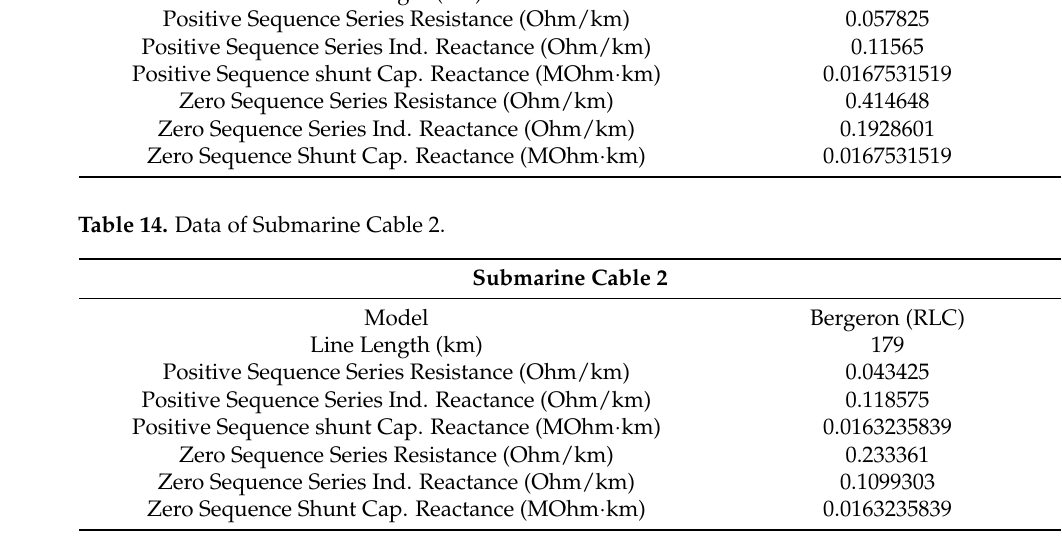
Table 15. Data of